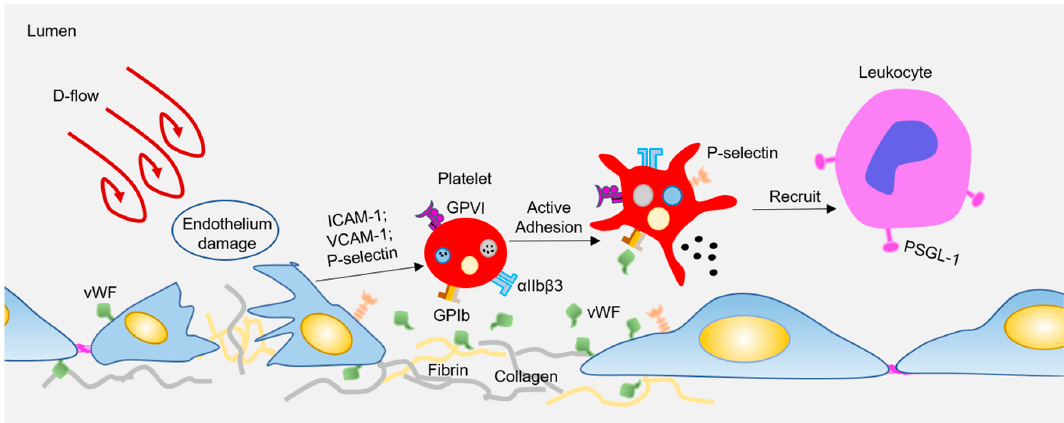
Figure 1. Disturbed flow-regulated platelets participate in the plaque formation. Disturbed flow activates endothelial cells (ECs), resulting in elevated expression of adhesion molecules and deposition of adhesion proteins. All these adhesion molecules and proteins interact with platelets via surface receptors, leading to platelet activation. Activated platelets recruit circulating leukocytes by P-selectin or other releasing inflammatory factors, therefore participating atherogenesis.